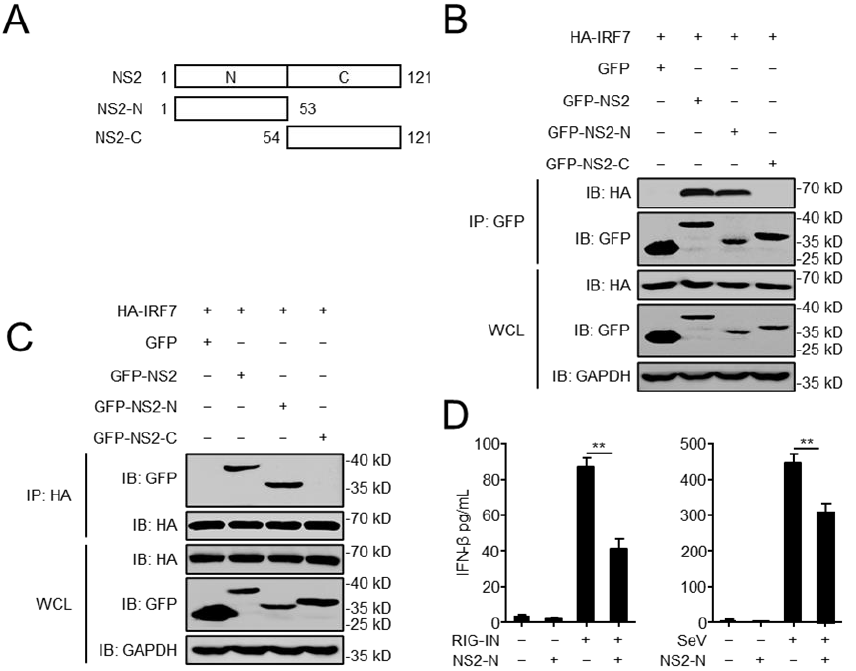
Figure 5. The N-terminal domain of NS2 is essential for the interaction with IRF7. ( A )